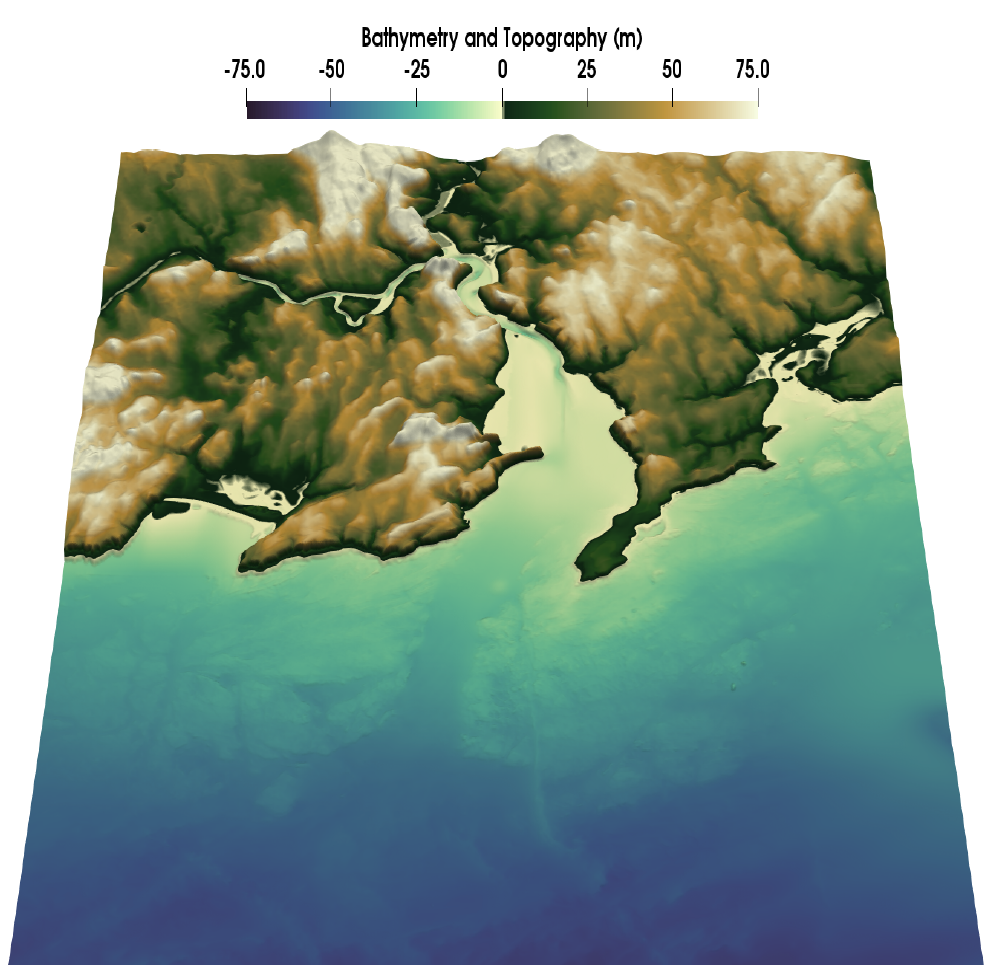
Figure 6. The high resolution bathymetry and topography grid generated for Dunmore East. The grid has been scaled in the vertical direction to give a 3D